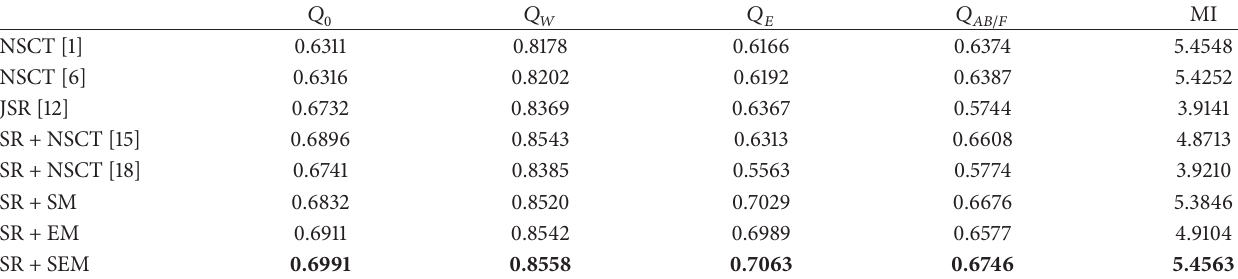
Table 2: The objective evaluation and running time for MR T1 and MR T2 image fused results of all methods.